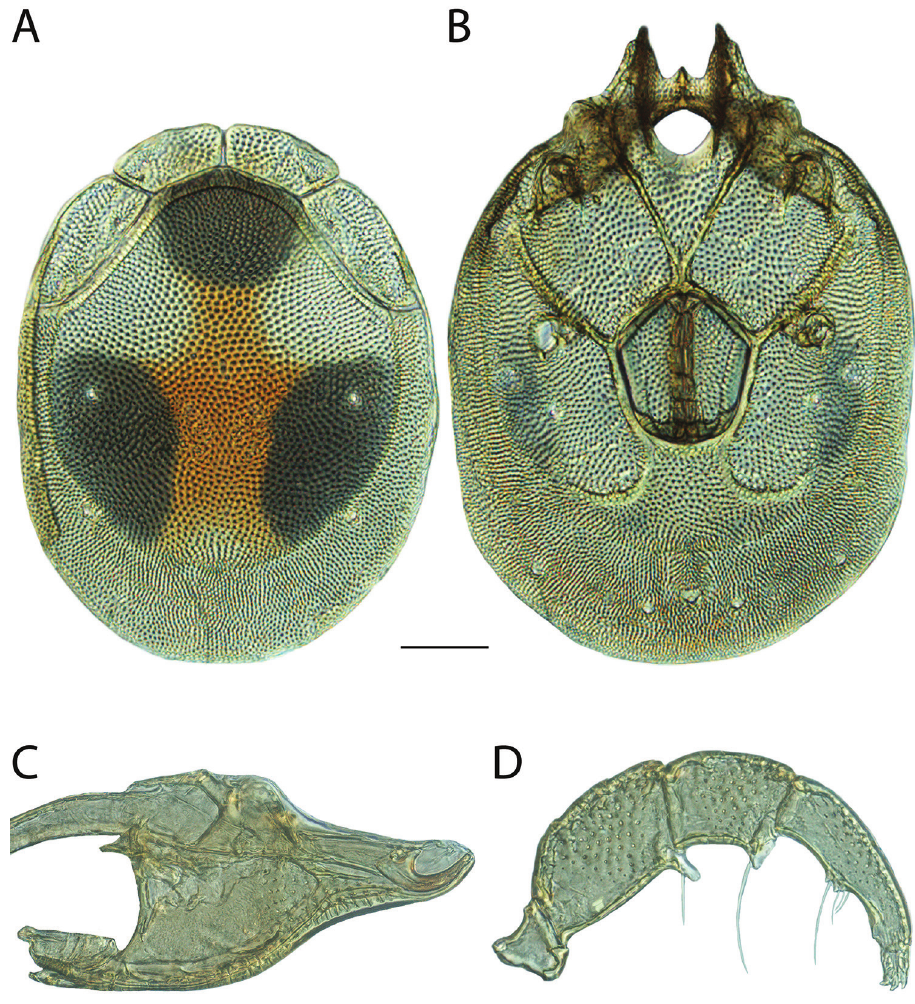
Figure 256. Torrenticola trimaculata female: A dorsal plates B venter (legs removed) C subcapitulum D pedipalp (setae not accurately depicted). Scale = 100